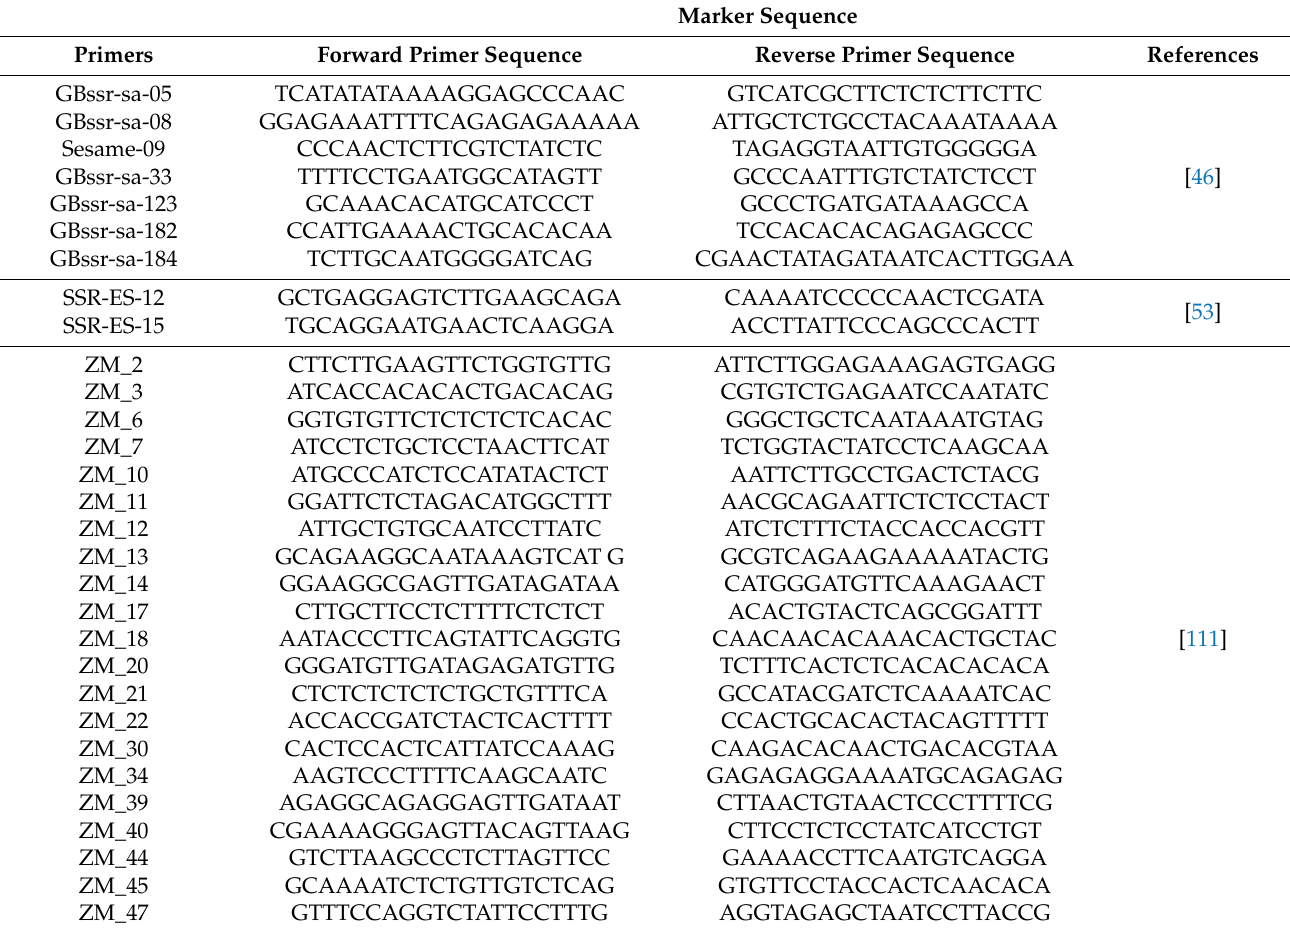
Table 7. Some polymorphic SSR markers developed for genetic analysis in sesame. Marker